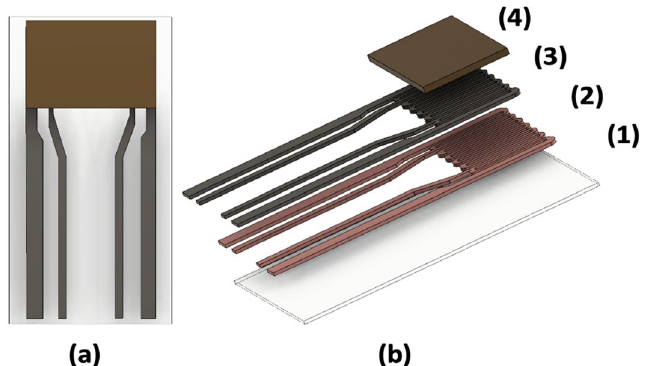
Figure 6. Top view of the thermodynamic sensor ( a ). Cutaway view of the thermodynamic sensor ( b ) showing the various layers comprising the sensor: YSZ substrate (1), copper adhesion layer (2), palladium microheater (3), and metal oxide catalyst